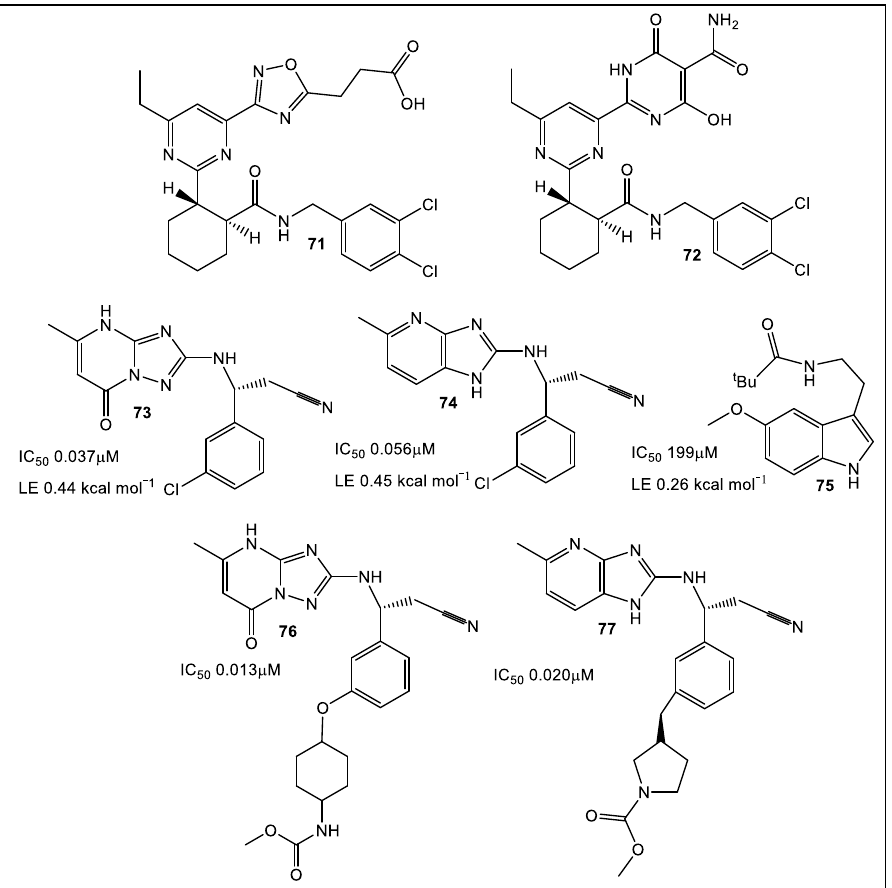
Figure 13. AstraZeneca PPAT inhibitors ( 71 , 72 ), and from Novartis lead compounds ( 72 , 74 ), and fragment hit 75 . When fragments co-crystalized with E. coli PPAT were examined, 75 , a methoxy tryptamine derivative, partly overlapped with 73 , although its interaction is different from fragment 73 . Fragments 73 and 74 served the basis for development of more than 50 analogs based on with improved on-target potency, including 76 , piperidine carbamate. Analysis of these analogs verified that compounds with an AZ benzimidazole core exhibited an enhanced ability to permeate Gram-negative bacteria. These findings eventually resulted in discovery of compounds, e.g., 77 , with anti- E. coli WT activity, which was confirmed by multiple methodologies (biochemical, SPR, and MICs). Regrettably, further progression of this series was halted due to bacterial efflux actions